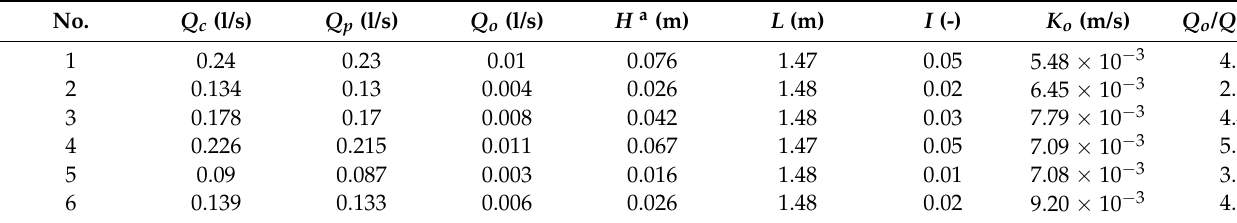
Table 6. Scenario C on a laboratory model of an extraction well.